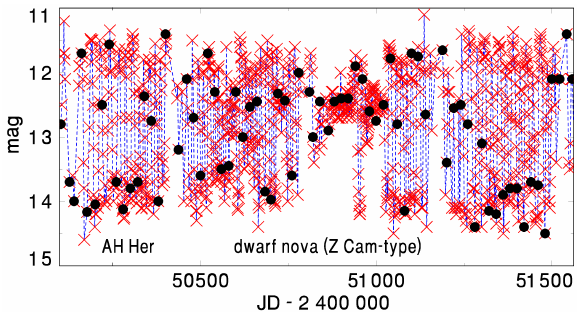
Figure 1: Comparison of the observed (one-day means of AFOEV data (crosses)) and the approximated sam- pled data of the dwarf nova AH Her (closed circles). Heavily sampled data are expected from the Gaia satel- lite. Notice that it is difficult to resolve the profile of the light curve in the sampled data.